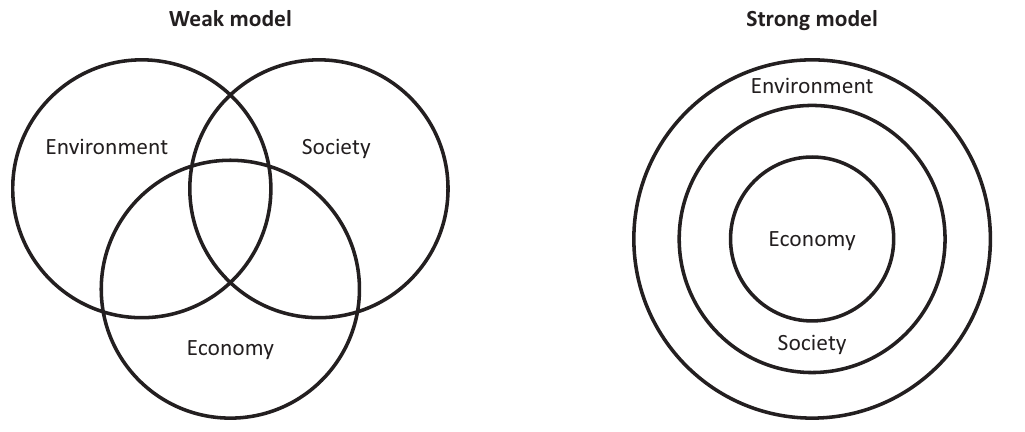
Figure 6. Weak and strong models of